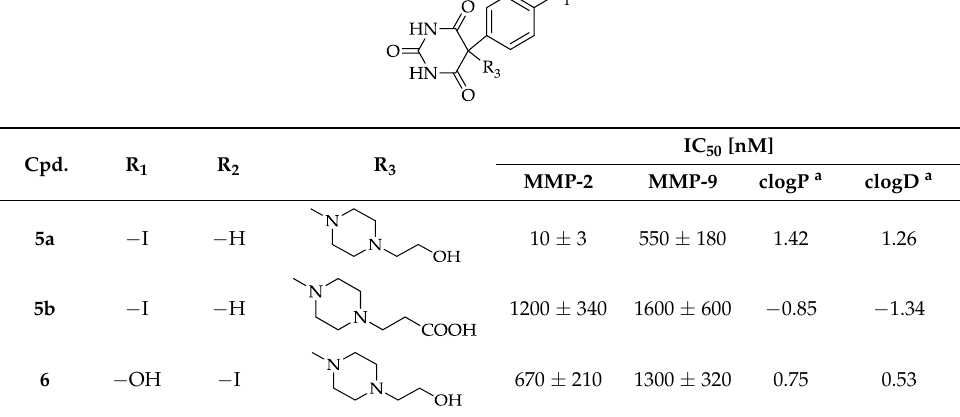
Table 1. IC 50 values of phenyl barbiturates 5a , 5b and 6 .